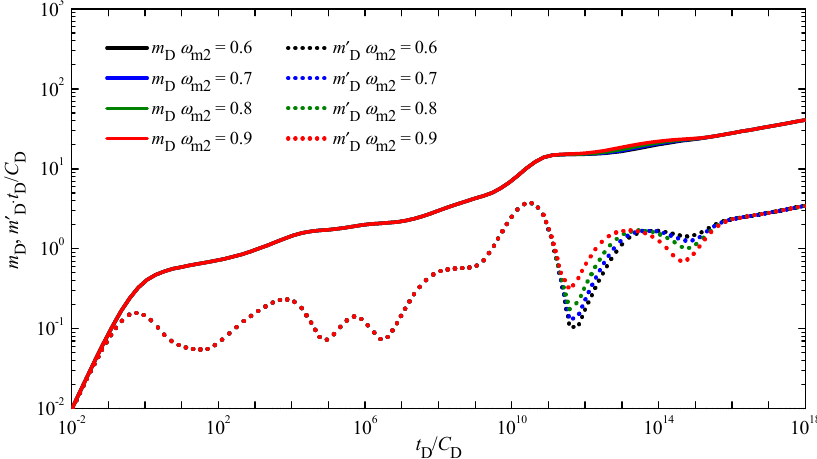
Figure 9. Influence of the outer–zone matrix storage ratio on the pressure type curve.